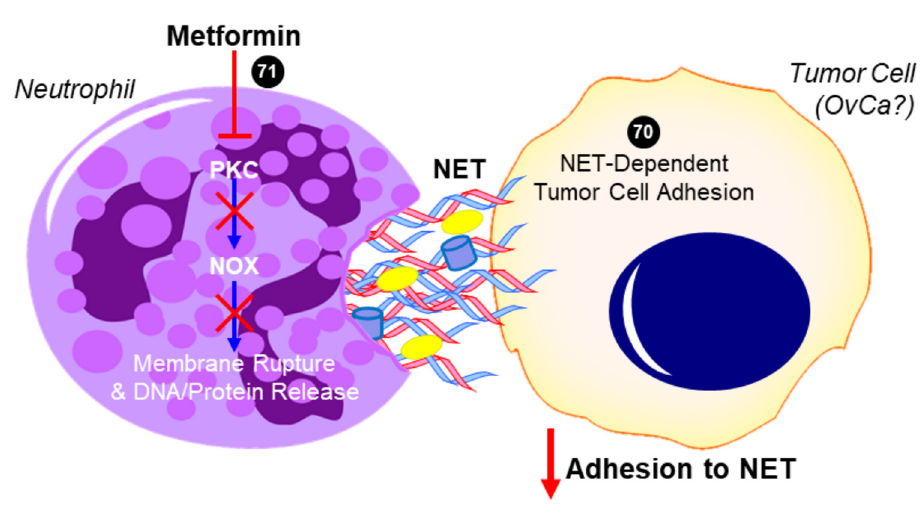
Figure 3. Proposed role of metformin in inhibiting neutrophil extracellular trap (NET)-induced tumor cell metastasis. In addition to decreasing neutrophil recruitment (not shown), metformin has been shown to inhibit protein kinase C beta II (PKC β II) translocation to the plasma membrane and prevent the downstream activation of NADPH oxidase (NOX) that would otherwise result in the expulsion of neutrophil extracellular trap (NET) components into the extracellular space [71]. Tumor cells have been shown to adhere to NETs, which contain DNA, histones, neutrophil elastase, and other proteins. In the case of ovarian cancer (OvCa), NET formation was especially critical to the ability of tumor cells to colonize the omentum in vivo, while having no effect on the primary tumor or other intra-abdominal sites [70]. The ability for metformin to inhibit this NET-dependent adhesion and colonization of the omentum has not yet been investigated but is a potential mechanism for its antitumor activity. Cited experiments are denoted by their respective reference numbers [70,71]. Blue arrows indicate activation, red arrows indicate inhibition, red T symbols indicate direct inactivation, and red X symbols indicate inhibition of this pathway by metformin.